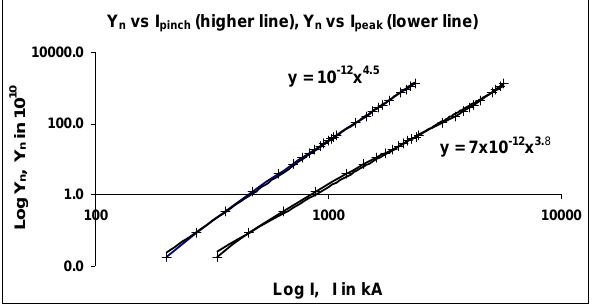
Figure 9. Log( Y investigated, up to 25